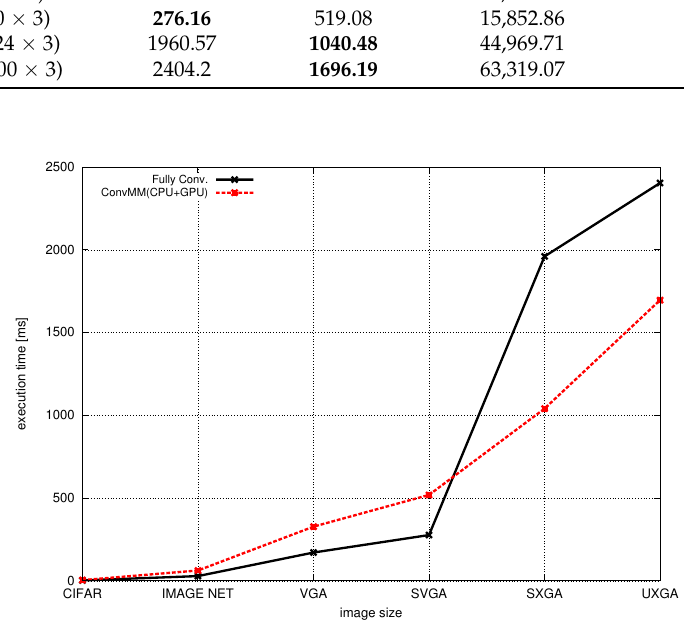
Figure 6. Full convolution vs. ConvMM as a function of input image size.